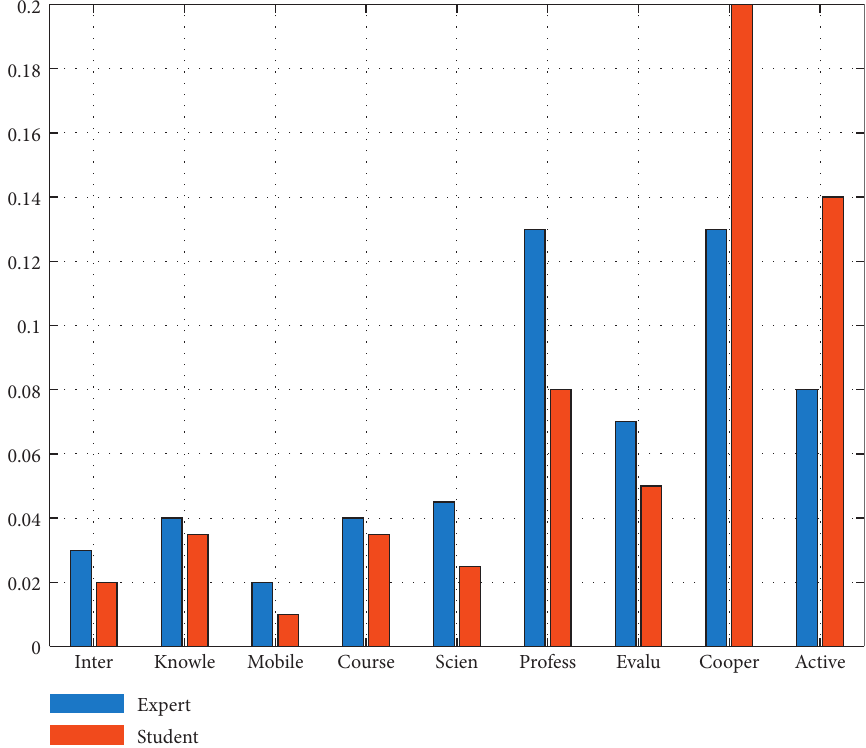
Figure 5: Comparison of the second-level indicator weighting results of experts and students.